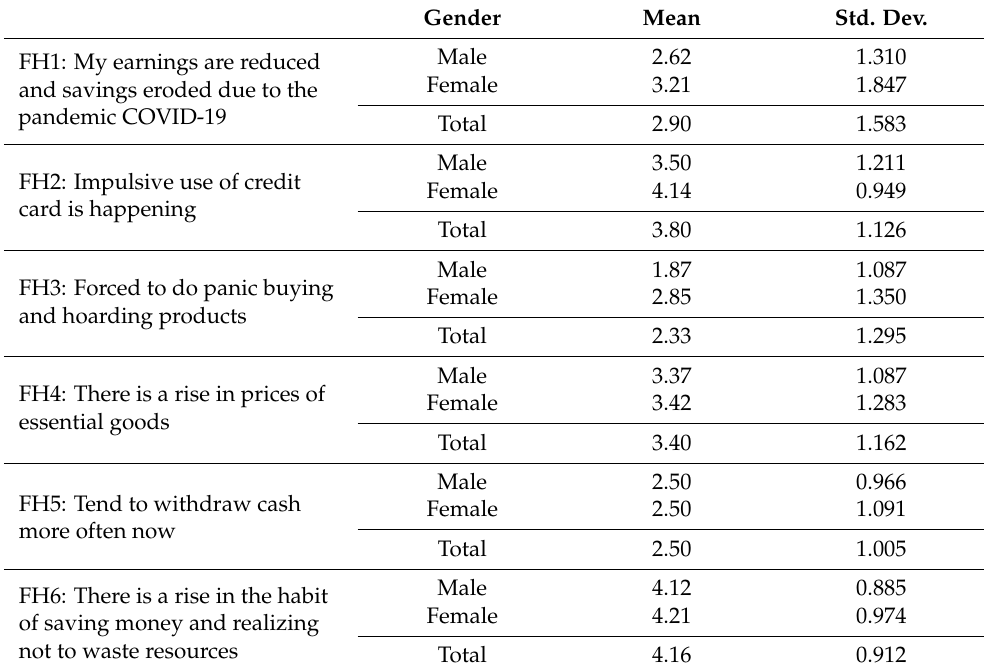
Table 18. General mean and mean by group (male and female) and total. Gender Mean Std. Dev.